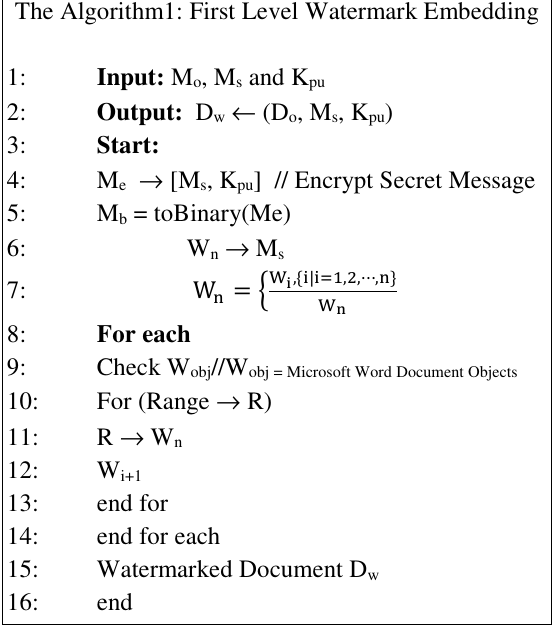
3.1.2 Second Level Embedding (Open Spaces) The open spaces are utilized for watermark embedding in second-level embedding. The open spaces are searched in the document and the watermark